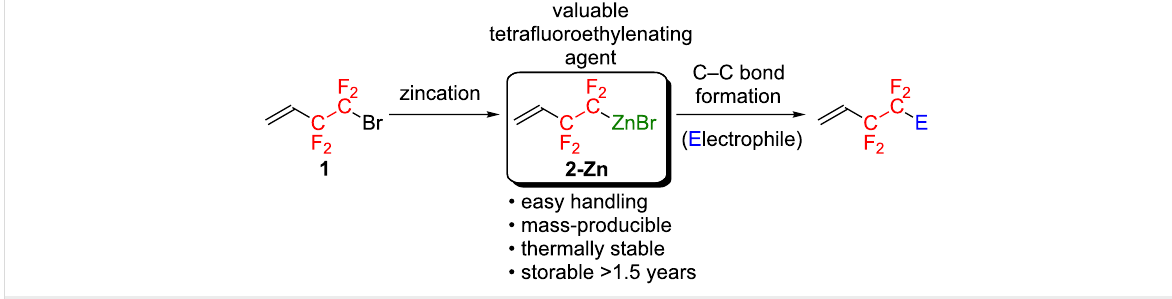
Scheme 1: Preparation and synthetic applications of 2-Zn .